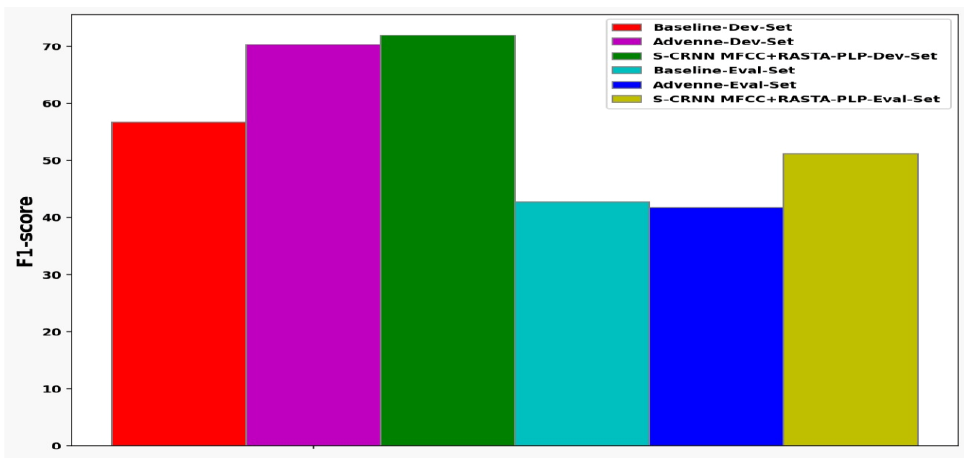
Figure 12. Overall F1-score comparison using S-CRNN Classifier .